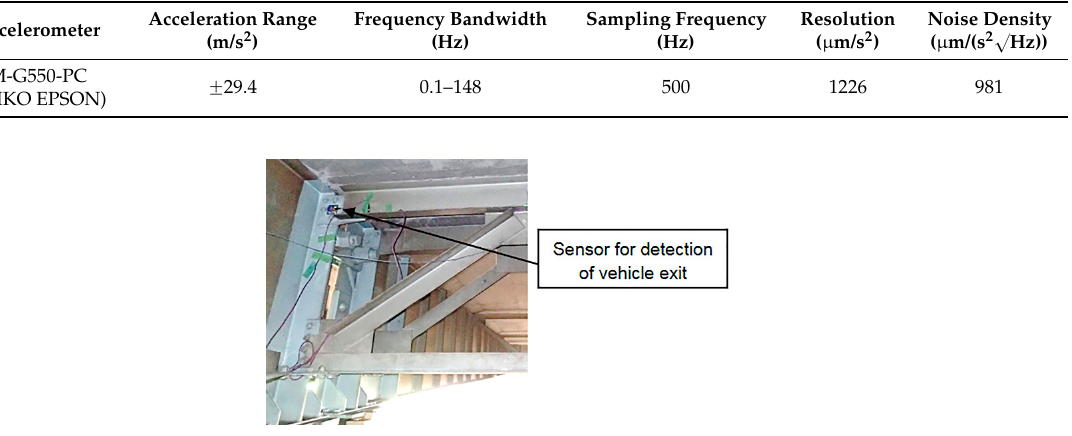
Figure 10. Installation of accelerometer for detection of vehicle exit.